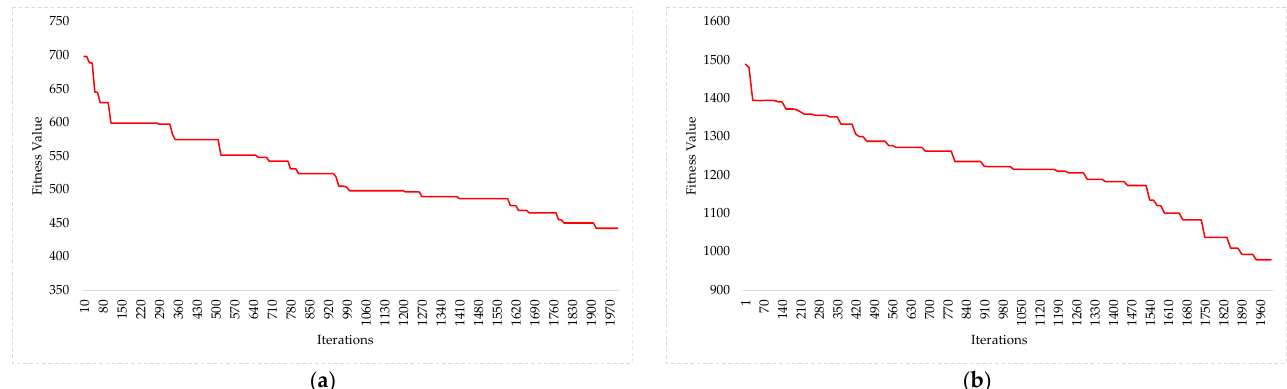
Figure 13. Objective function vs. iterations in the genetic algorithm considering ( a ) 20 jobs and ( b ) 30 jobs. Table 5. Number of tardy jobs for the GA compared to the benchmarks.